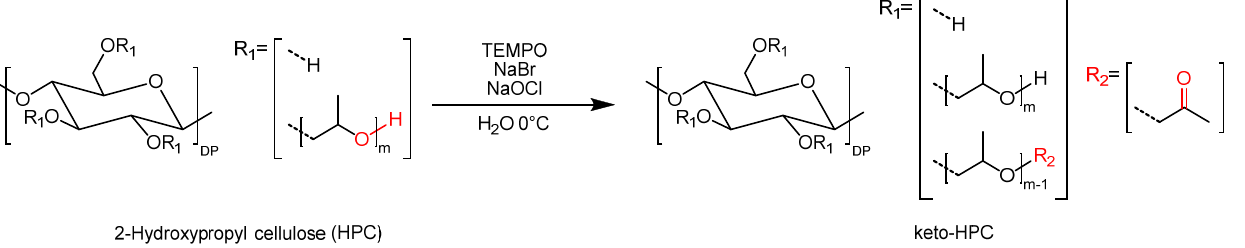
Figure 1. Introduction of carbonyl functions into HPC by TEMPO-mediated oxidation.